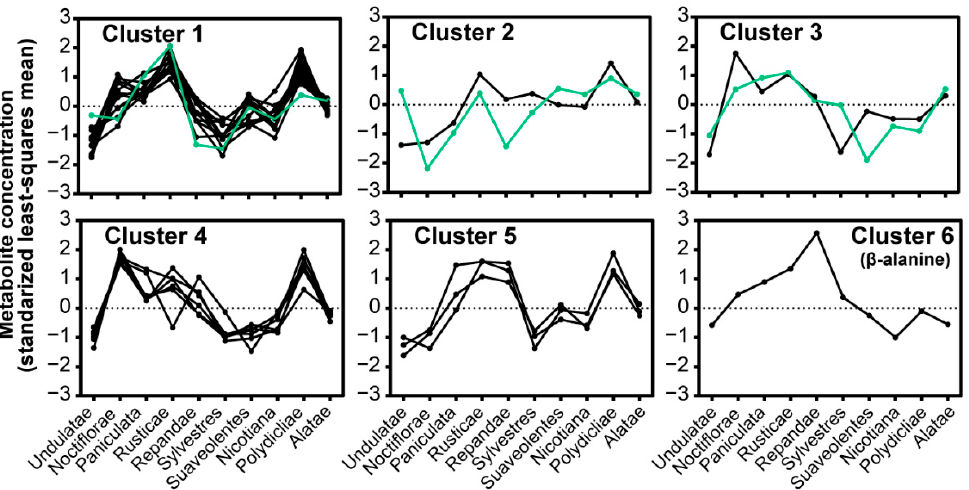
Figure 4. Hierarchical clustering analysis of the 27 quantified nectar metabolites grouped by Nicotiana Phylogenetic section. The three sugars are highlighted in green with fructose, glucose, and sucrose in Clusters 1, 2, and 3, respectively. Description of the amino acids within each cluster is provided in